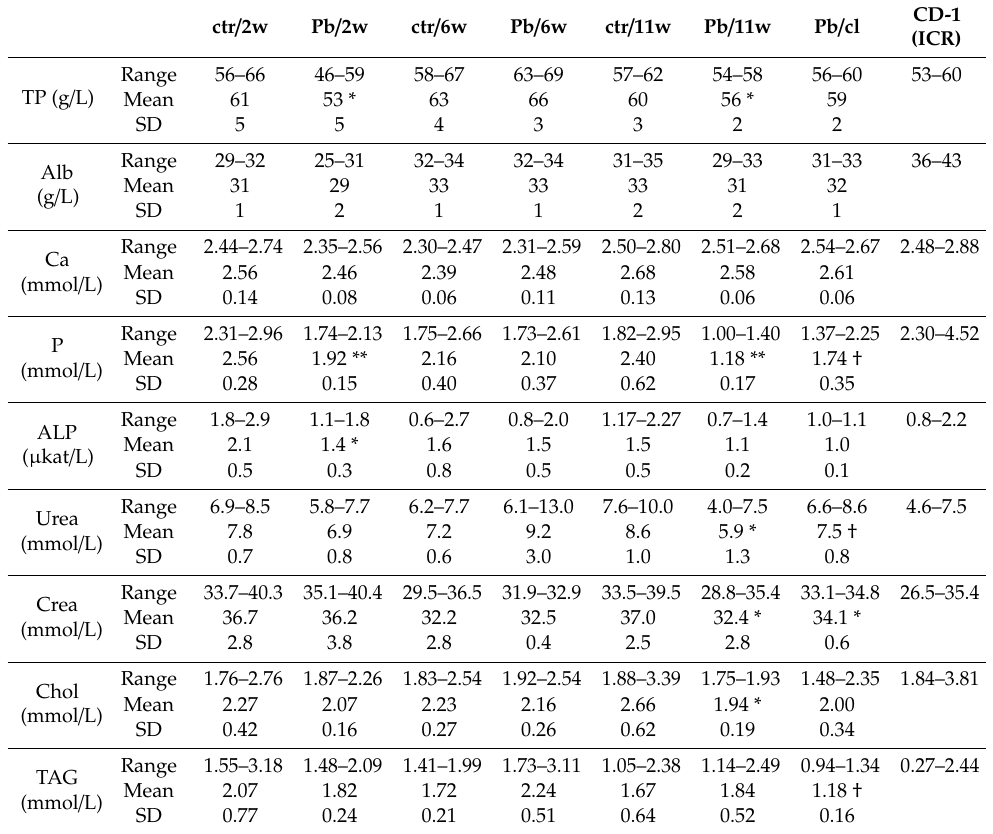
Table 4. Blood biochemical analysis following Pb(NO 3 ) 2 NP